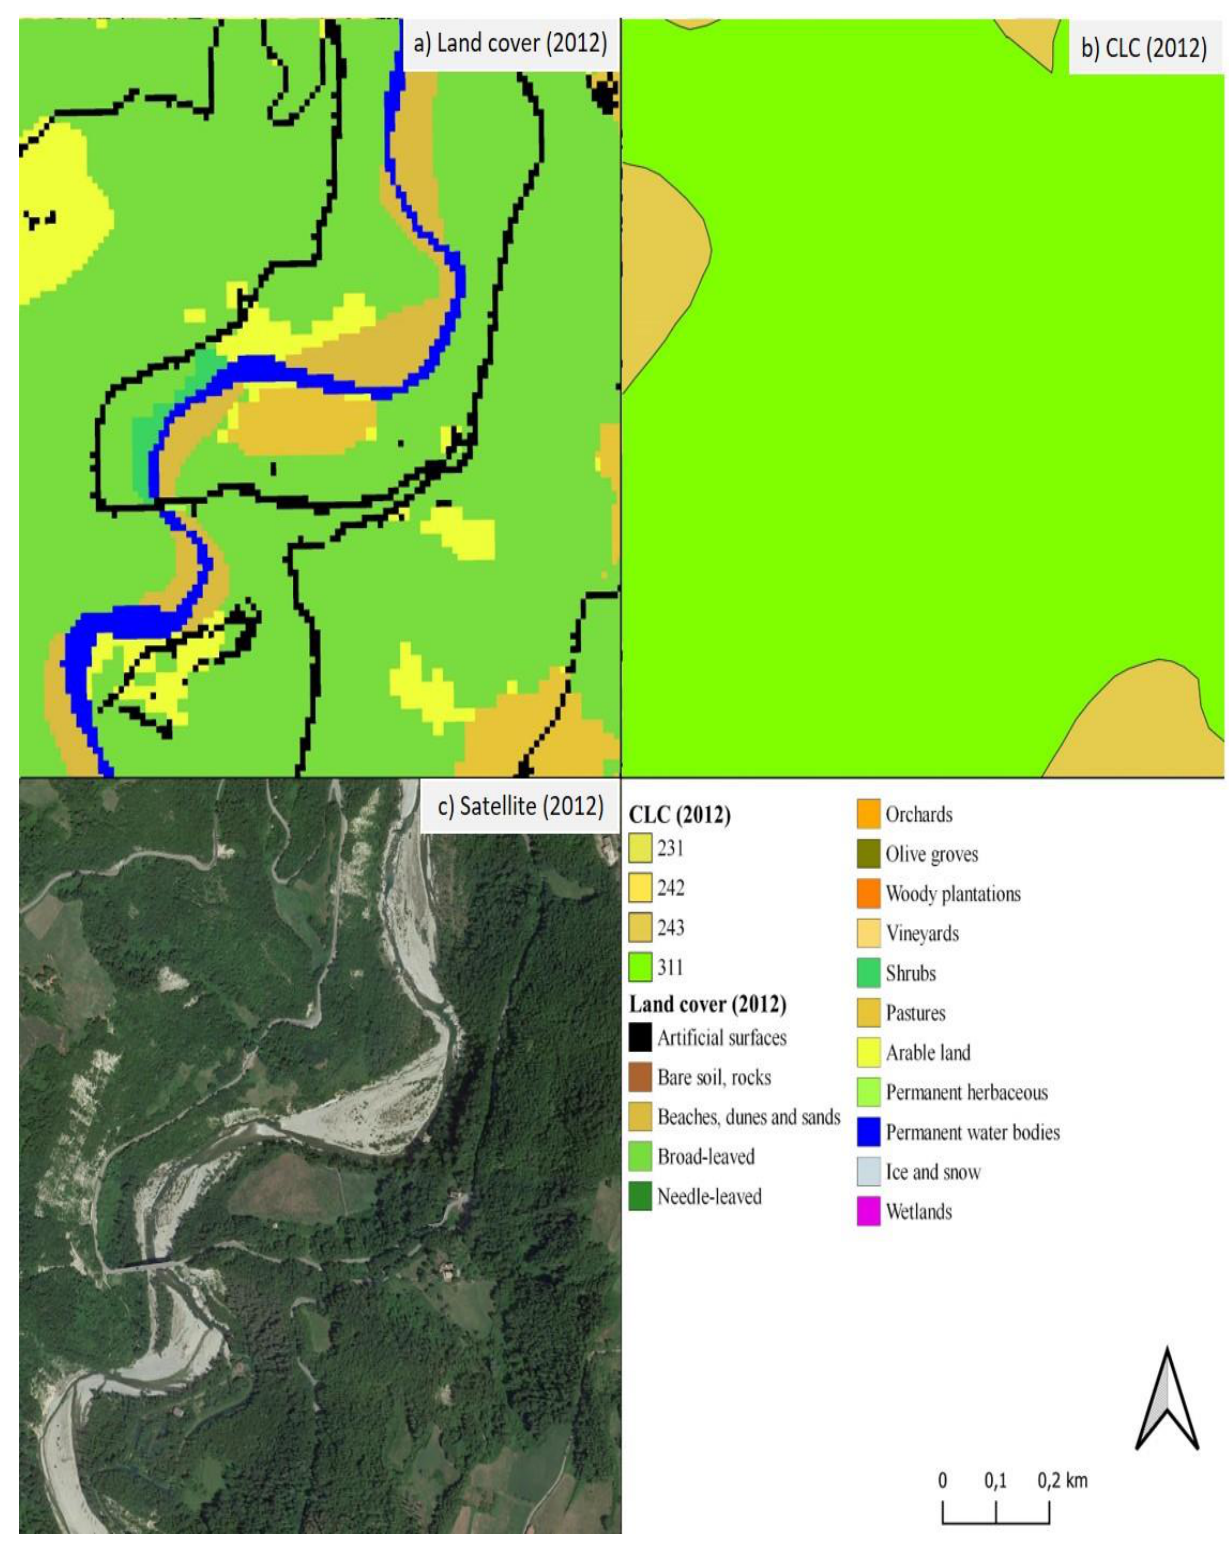
Figure 7. Comparison between land cover map for 2012 ( a ), CORINE Land Cover ( b ) and satellite image ( c ), focusing on water courses.